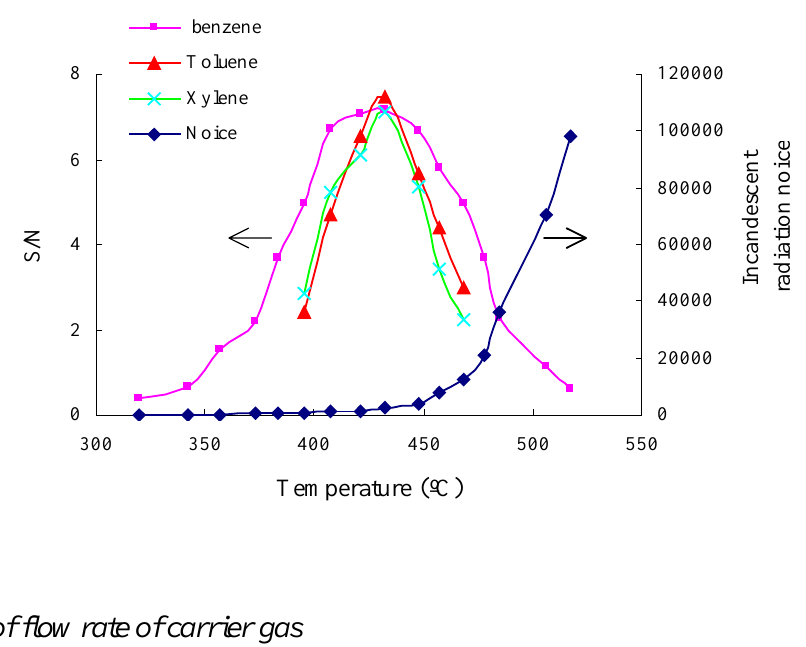
Figure 5. Temperature dependence of CTL intensity of benzene homologue